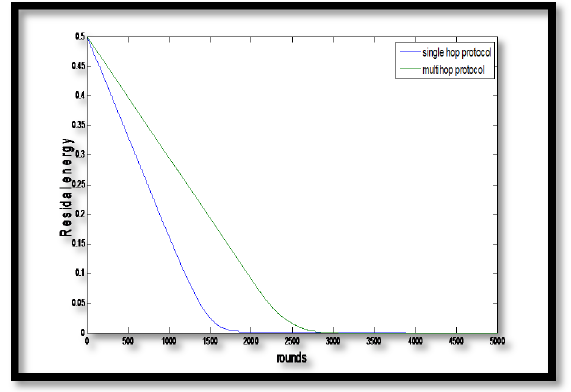
Fig. 5.Complete energy of the system against broadcast rounds for single hop and multi hop protocols.